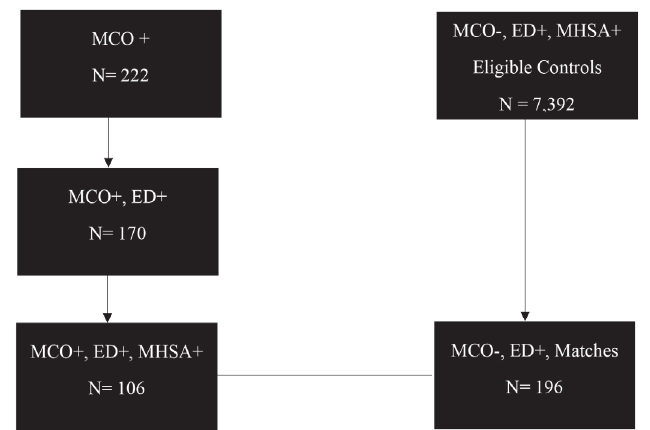
Figure 1. Flowchart of sample